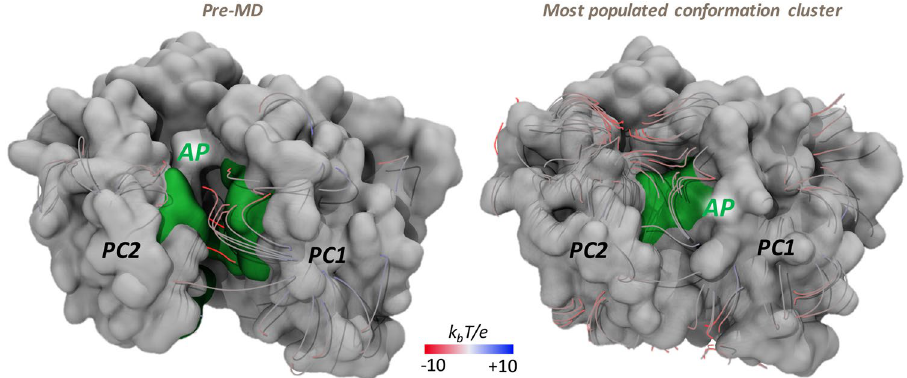
Figure 11. Electrostatic funnel converging into AP in the Loose protomer of AcrB. Only the strongest field lines are shown and coloured red to blue from negative ( − 10 k b T/e) to positive ( + 10 k b T/e) potential (‘k b ’ is the Boltzmann constant, ‘T’ is absolute temperature and ‘e’ is charge of an electron). AP is shown in green and the rest of the porter domain in white surface